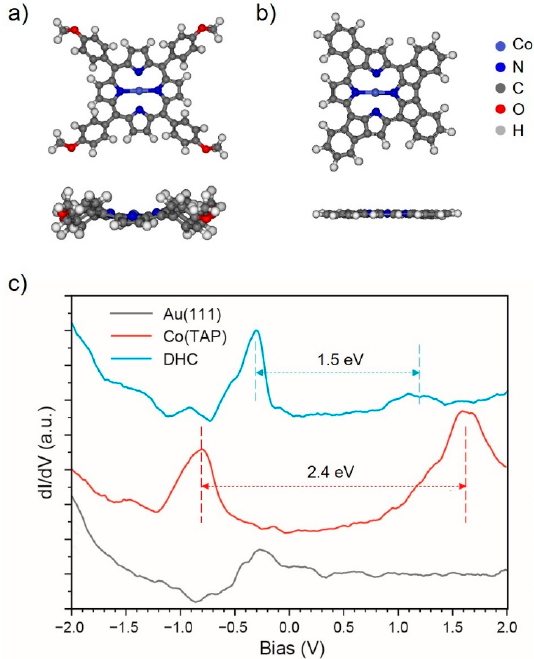
Figure 2. Bird and side views of the optimized structures of ( a ) Co(TAP) and ( b ) DHC products in free space; ( c ) STS spectra acquired on Au(111), Co(TAP) and DHC product.